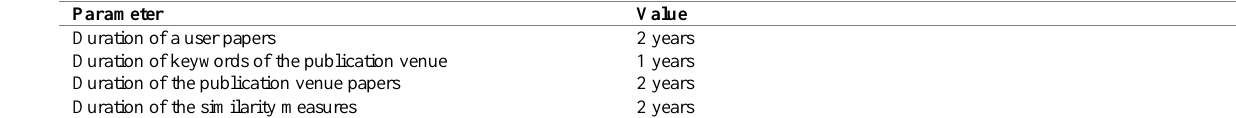
Table 5. Constant parameters in the